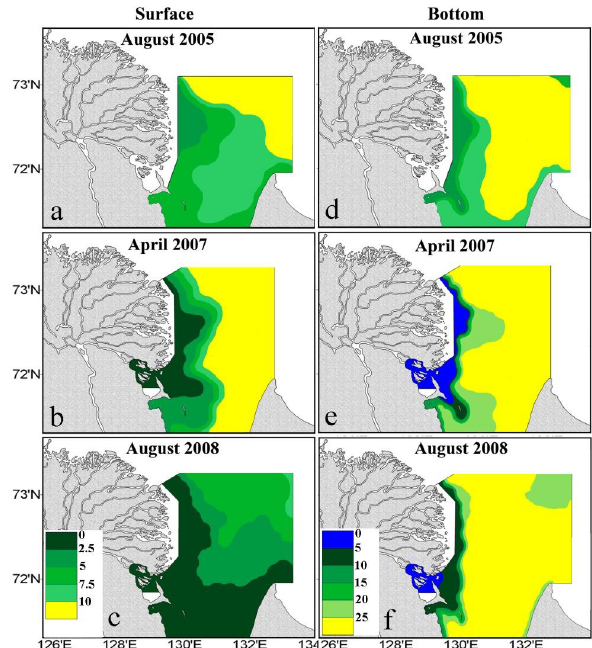
Fig. 4. Salinity of the surface and bottom Buor-Khaya Bay water layers. Salinity levels are shown as colored rectangles in (c) and (f) .